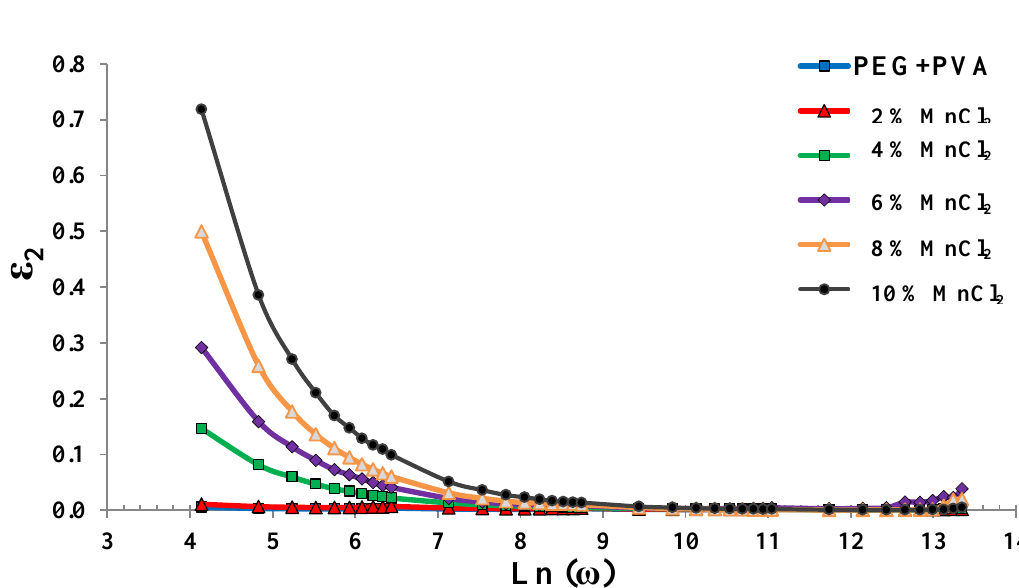
Fig. 4B: Variation of the dielectric loss with frequency for PVA:PEG-MnCl